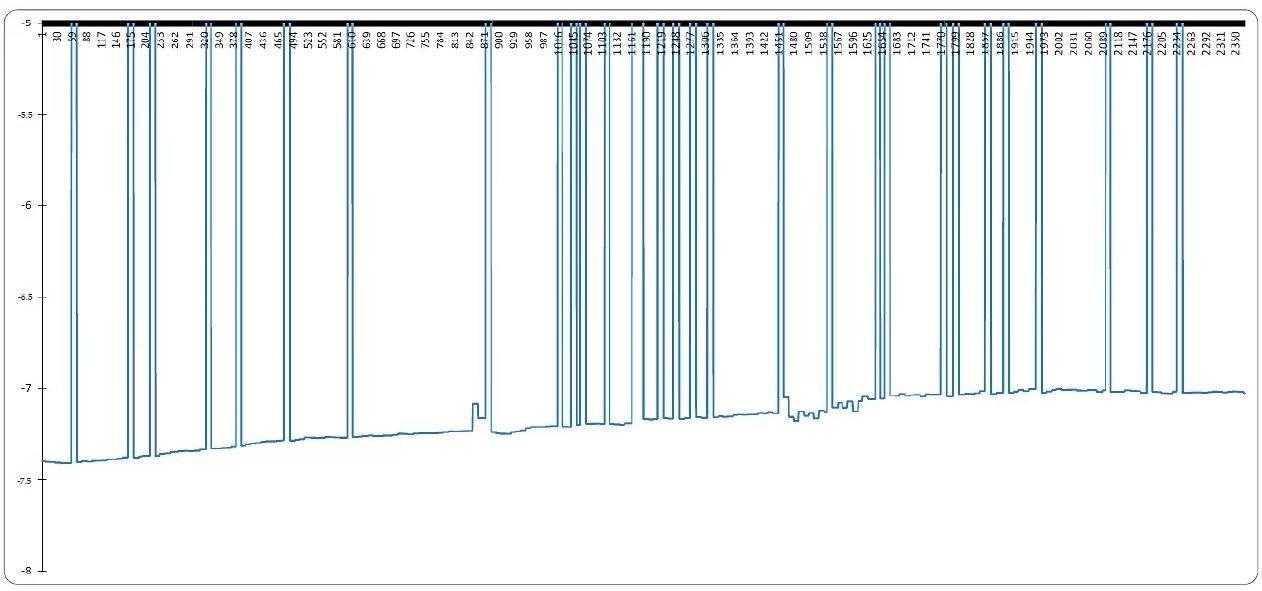
Figure 15. Characteristic of the output signal at a stress in the soil of 0 MPa. During the period of occurrence of stresses in the soil from 0 to 0.75 MPa (see Figure 16), it was not possible to obtain unambiguous data on the appearance of an input signal in the measurement system. Stresses in the range of 0.75–2.0 MPa were recorded with the possibility of their unambiguous interpretation.